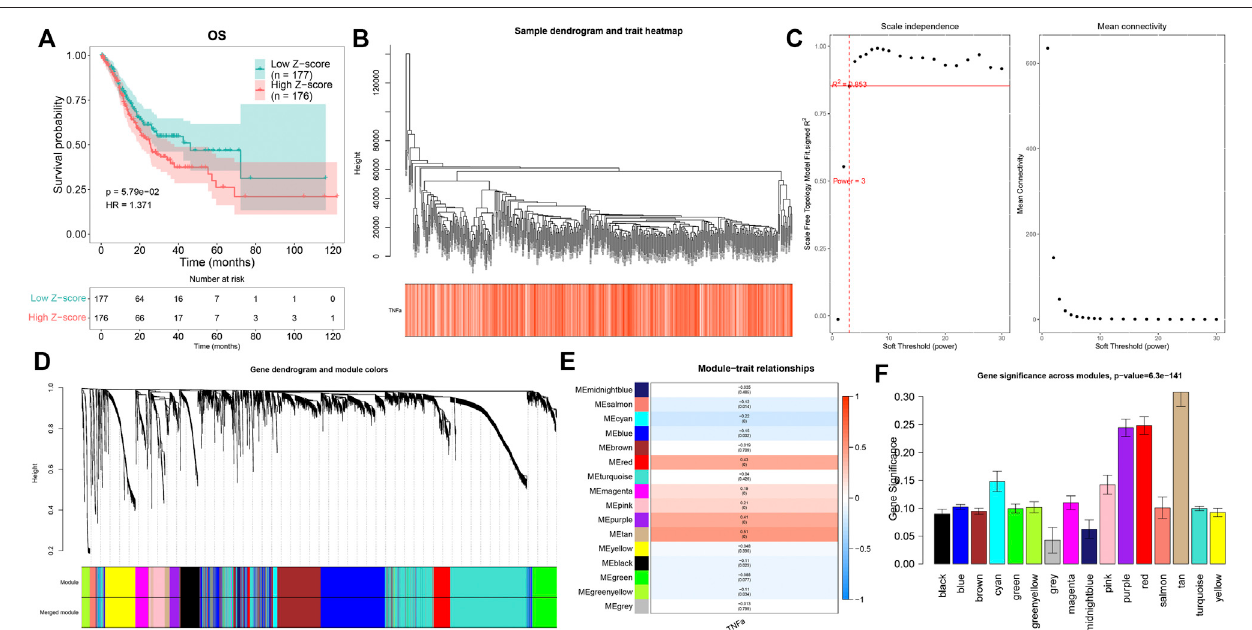
FIGURE1| Quanti fi cationoftheTNF α scoreasaprognosticindicatorandidenti fi cationofTNF α -derivedgenes. (A) Kaplan – MeiercurvesofOSforGCpatientswith highandlowz-scoreofTNF α signaling. (B) Hierarchicalclusteringfordetectionofoutliersamples. (C) Determinationofscaleindependenceandmeanconnectivityunder diversesoftthresholds.Theredlinecorrespondedto0.853.Soft-thresholdingpowerwassetas3afterconsideringbothscaleindependenceandmeanconnectivity. (D) Hierarchical cluster analyses for detecting co-expression modules assigned by distinct colors. (E) Heatmap displaying the Pearson correlation of co-expression modules with the TNF α score. (F) Gene signi fi cance across co-expression modules.